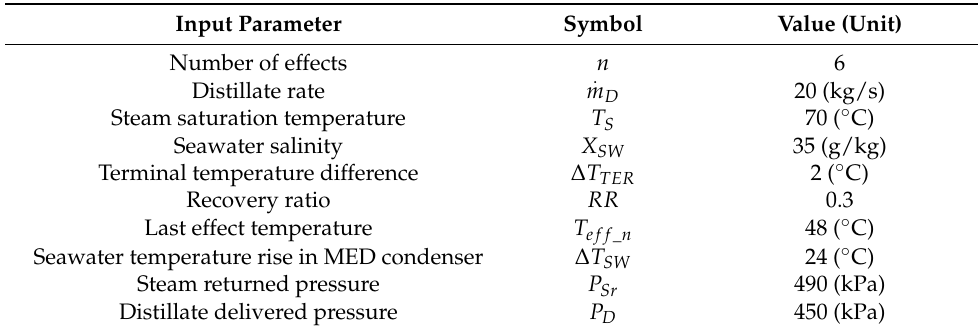
Table 3. Technical input data of multi-effect distillation with thermal vapor compression (MED) unit